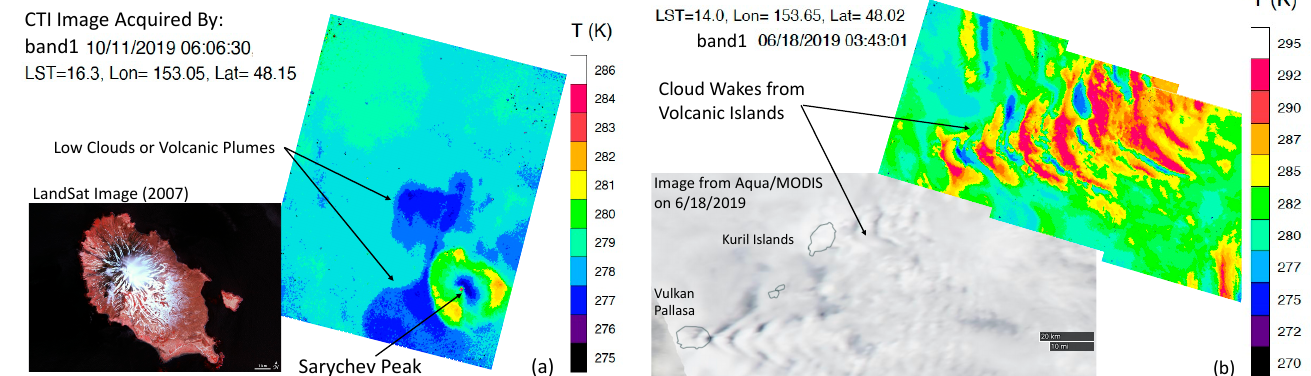
Figure 11. ( a ) Volcanic plumes/clouds from Sarychev Peak as observed by CTI band1 on 11 October 2019 at LST = 16.3 h; ( b ) cloud wakes from volcanic islands observed on 18 June 2019 at LST = 14.0 h. Three consecutive CTI images are stacked together to create a longer image of cloud wakes.